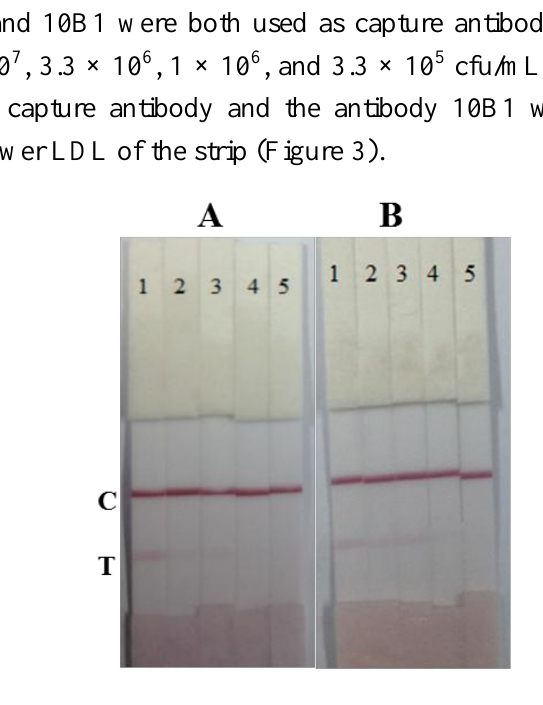
Figure 3. The optimization of antibodies for immunochromatographic strip. ( A ) Antibody 10B1 as the capture antibody and 12B4 as the gold-labeled antibody; ( B ) Antibody 12B4 as the capture antibody and 10B1 as the gold-labeled antibody; the concentration was as follows: (1) 1 × 10 7 , (2) 3.3 × 10 6 , (3) 1 × 10 6 , (4) 3.3 × 10 5 cfu/mL and (5) blank. T, test line. C, control